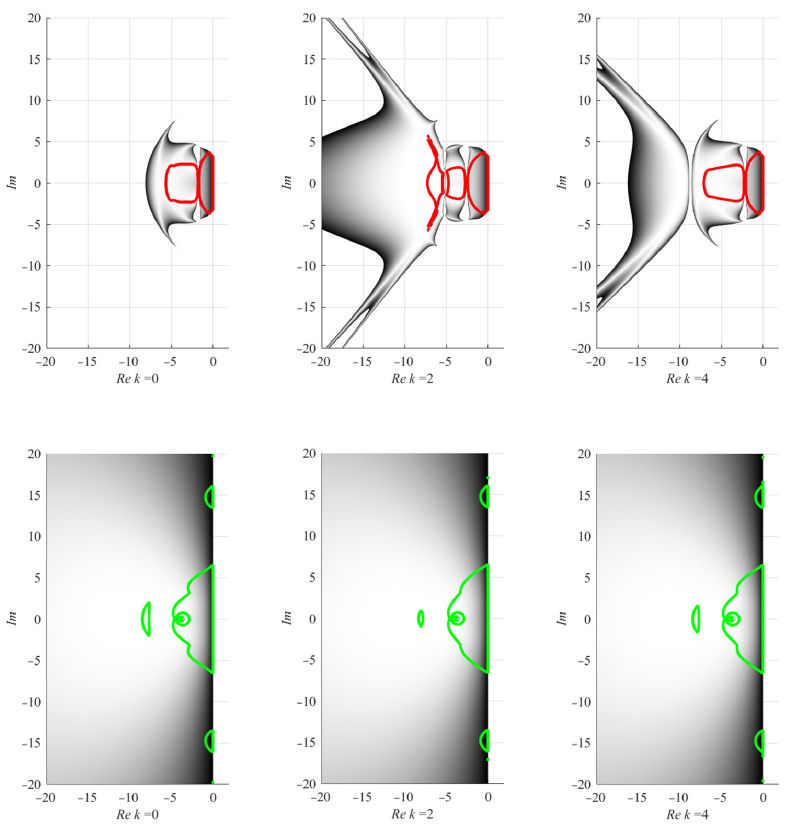
Figure 8. Stability regions of XB4 composition scheme using semi-implicit CD solver as a basic method.